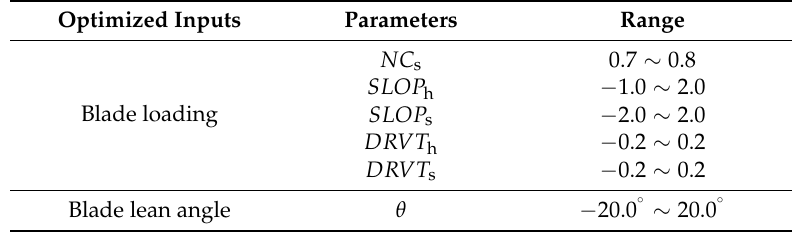
Table 3. Variation range of input parameters.